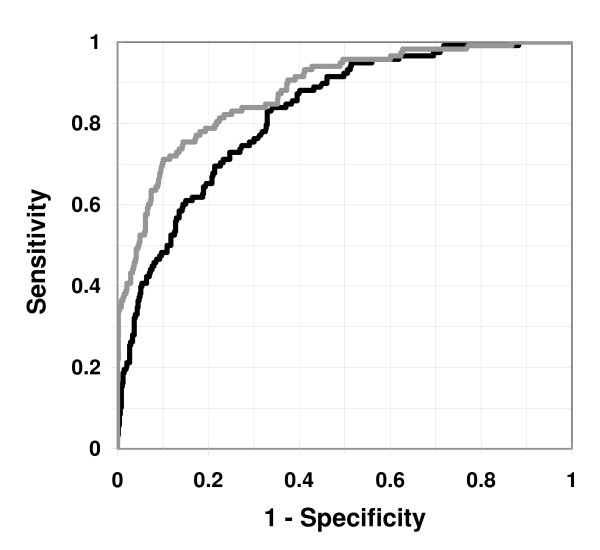
Receiver-operating-characteristic curves (ROCs) for the prediction model with ECG and other clinical characteristics (black curve; area under ROC = 80.6%, n = 627a) and for the prediction model based on expert assessment of the ECG together with clinical characteristics (gray curve; area under ROC = 88.0%, n = 605b). a Data on at least one of the characteristics were missing for 7 (4 with ACS and 3 without ACS) of the original 634 patients. b Data on at least one of the clinical characteristics were missing for 3 (1 with and 2 without ACS) of the 608 patients with ECG assessed by the experts.